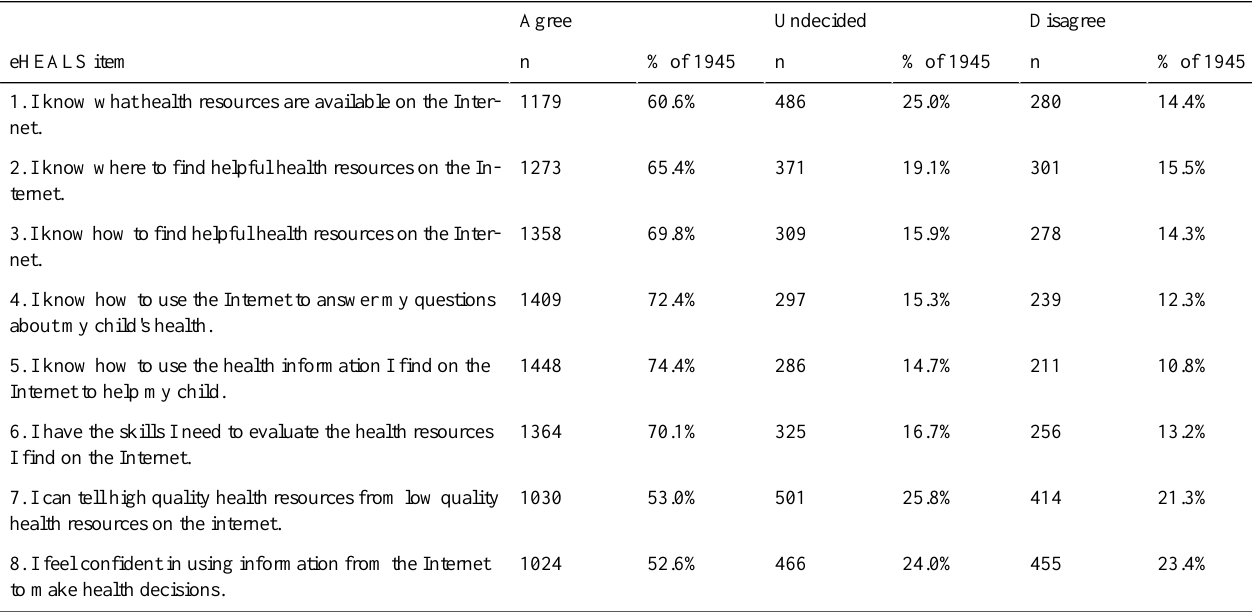
Table 4. Response frequencies to eHEALS items